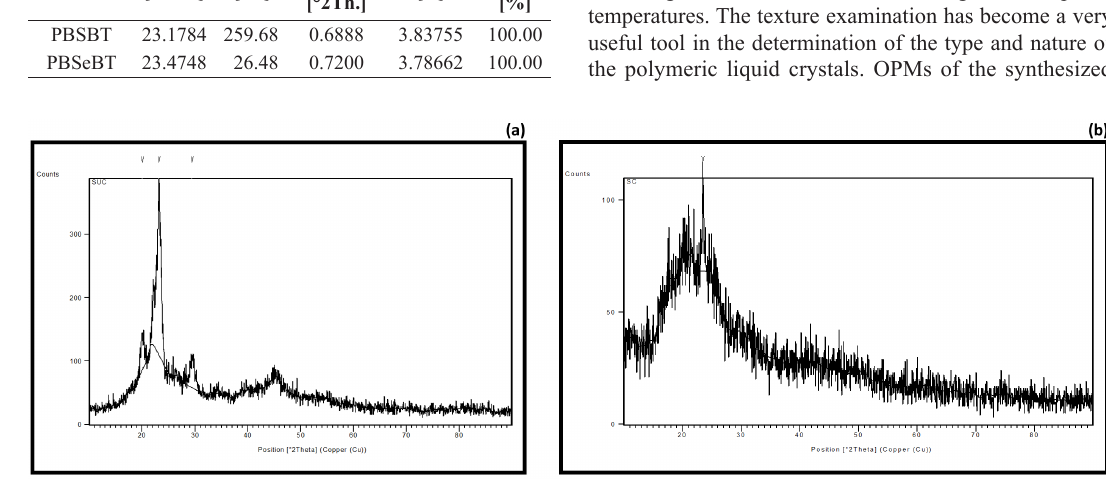
Table.2: XRD parameters of PBSBT and PBSeBT copolyester Poly